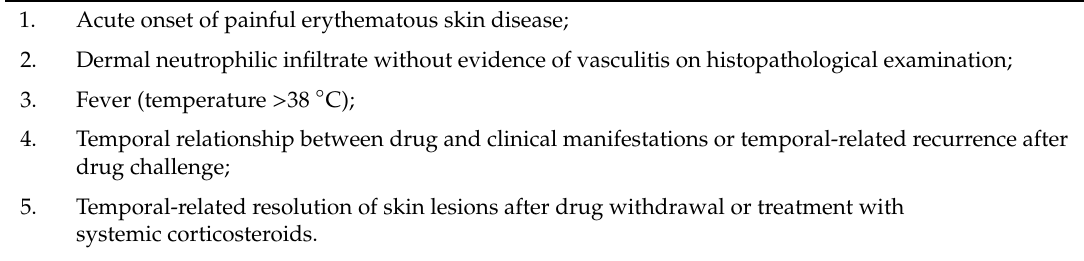
Table 3. Diagnostic criteria for drug-induced Sweet’s syndrome (DISS) proposed by Walker and